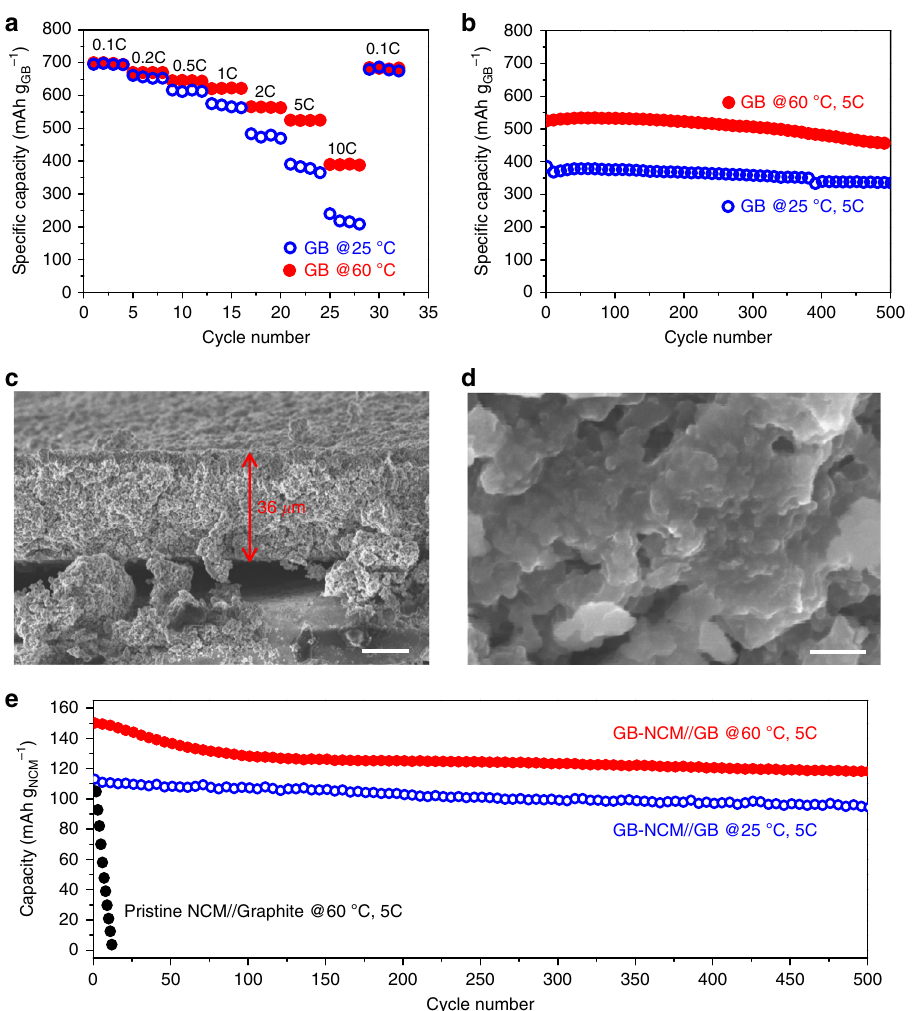
Fig. 5 The electrochemical tests of the GB anode in half-cell and full-cell con fi gurations. a Rate capability of the GB anode in half-cell when measured at various C-rates (1C = 700 mA g − 1 ) at 25 and 60 °C. b Cycle life of the GB anode at 25 and 60 °C when measured at 5C in half-cell. c Cross-sectional SEM image of the GB anode after 500 cycle at 5C (scale bar, 15 µ m). d A magni fi ed view of c (scale bar, 200 nm). e Cycle life of the GB-NCM/GB full-cell at 25 and 60 °C when measured at 5C. The initial areal capacities of the GB anodes in half-cell and full-cell are 2.7 and 2.4 mAh cm − 2 , respectively. In each cycle, charging and discharging rates were the same for all the data shown in this fi